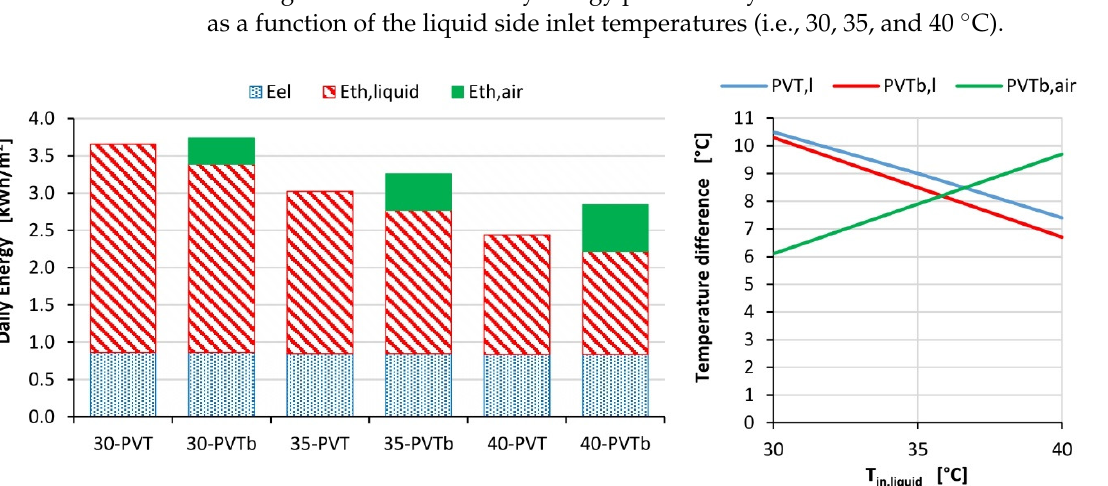
Table 4. Energy yields of conventional water-based (PV/T) and bi-fluid collector (PVTb). E el [kWh/m 2 ]